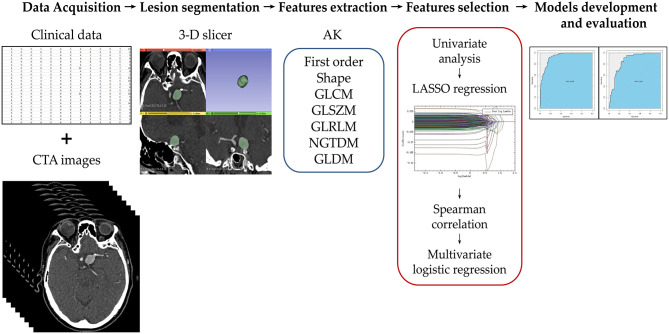
Illustration of the study workflow. Clinical and imaging data of the potential candidates were collected and assessed for enrollment eligibility. The aneurysms were segmented by two radiologists using 3D slicer software. Seven groups of radiomics features were extracted using Artificial Intelligence Kit (AK). The feature number was reduced using a step-wise process. The selected radiomics features were used to build the radiomics model. The model was evaluated using the area under receiver operating characteristic curve on training and test cohorts.